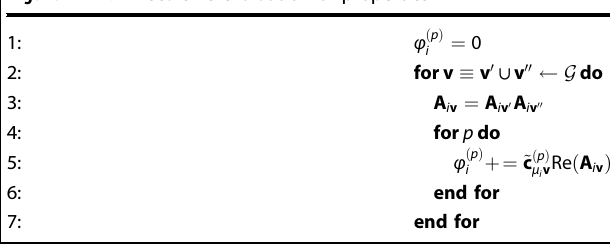
Algorithm 2R. Recursive evaluation of